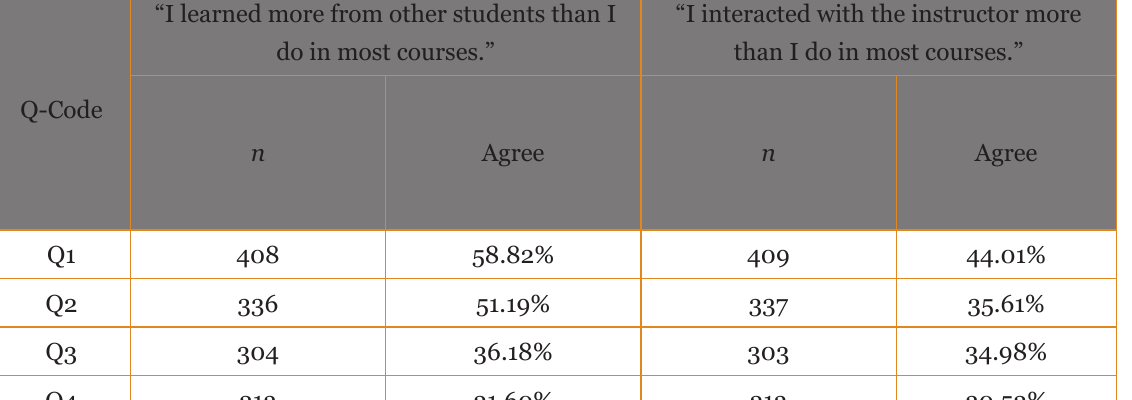
Q1 408 58.82% Q2 336